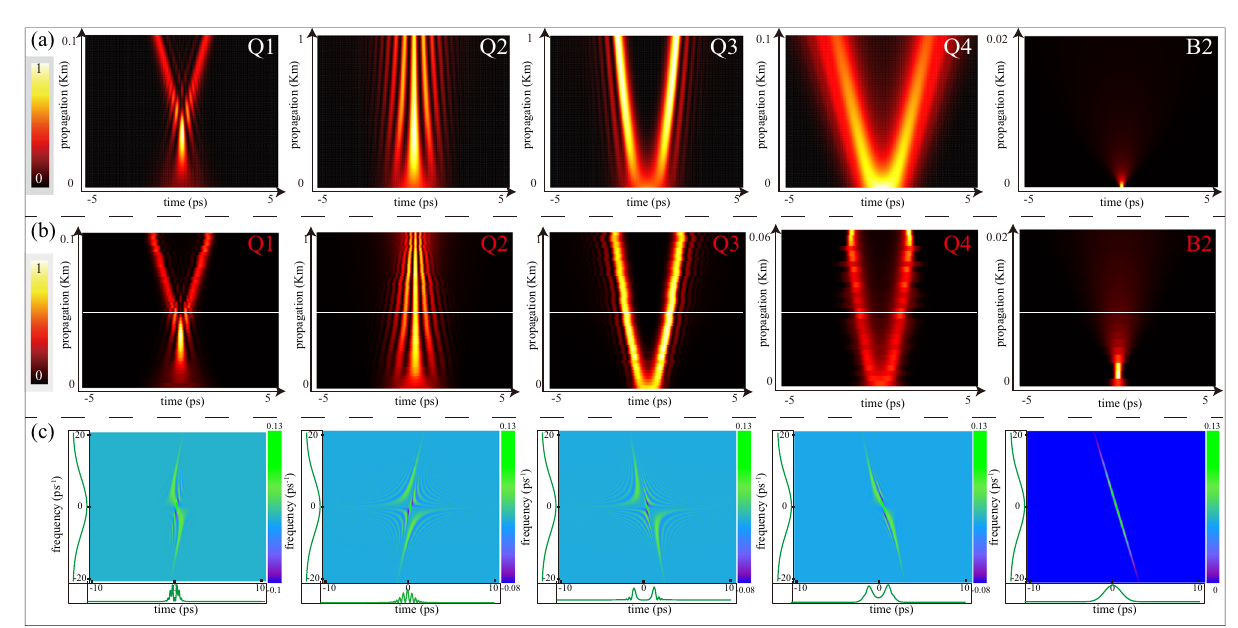
β − 21×10 − 3 ps 2 /m, respectively. b Experimental results for cases Q1 – Q4 and B2. 2 = c The Wigner functions in the time – frequency space, plotted along the white horizontallinesmarkedinallpanelsQ1toQ4andB2inrow( b ).Inpanelsbelonging torow( c ),timevariesbetween − 10and+10ps,whilethefrequencyvariesbetween − 20and+20ps − 1 .Thecolor-codinginthesepanelsrepresentstherelativeintensity, which is normalized to take values uniformly from minimum to maximum.